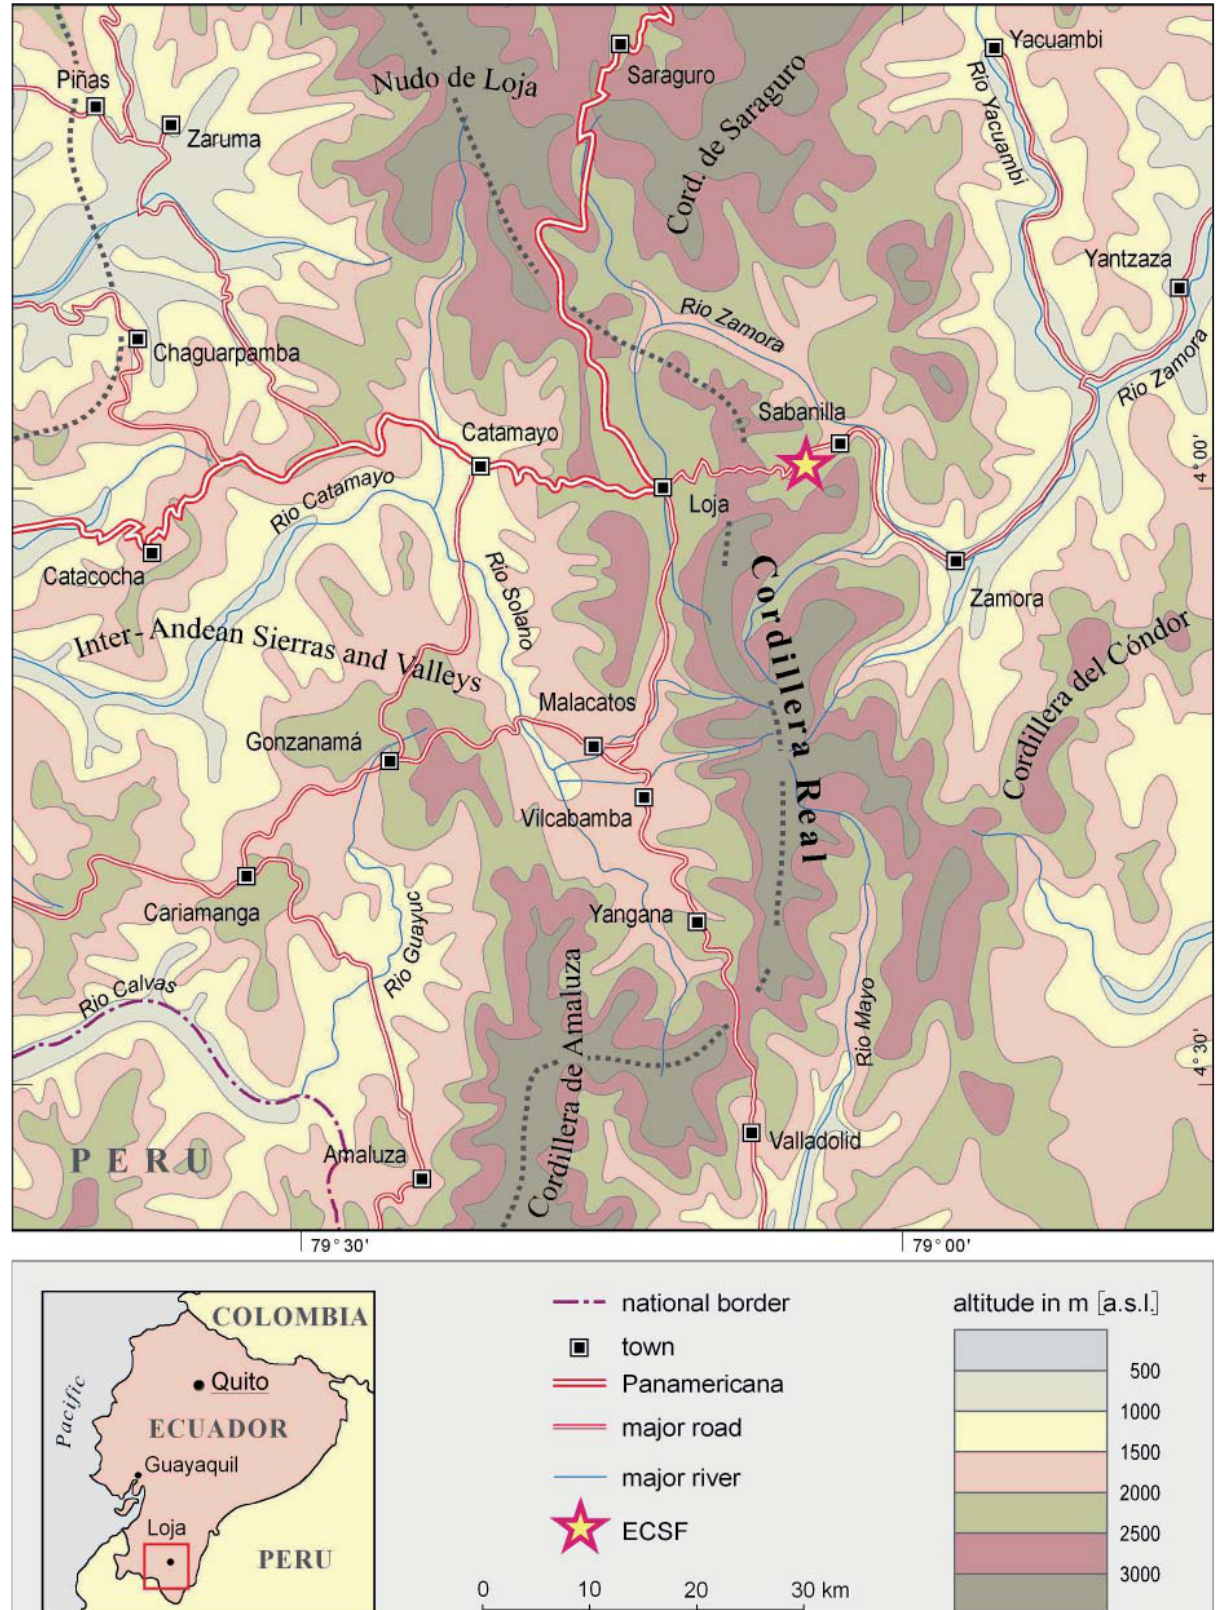
Figure 3: Location of the Cordillera Real and the research station (ECSF) in southern